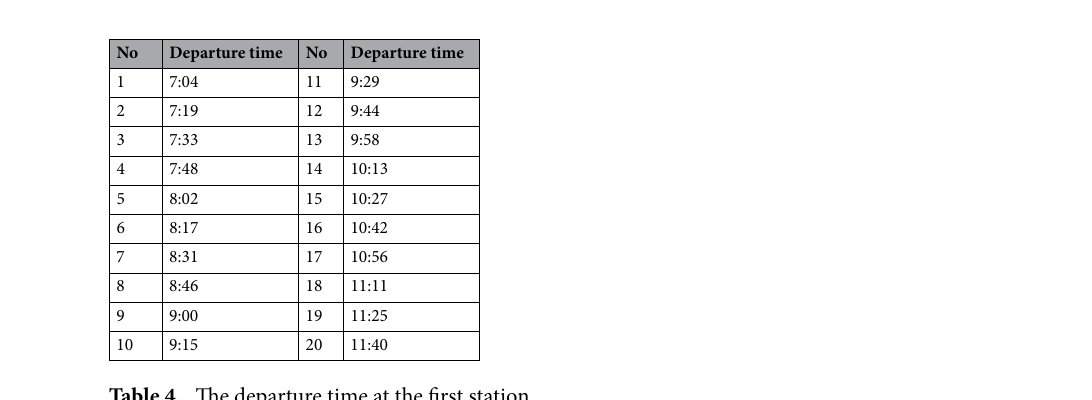
Table 4. The departure time at the first station.